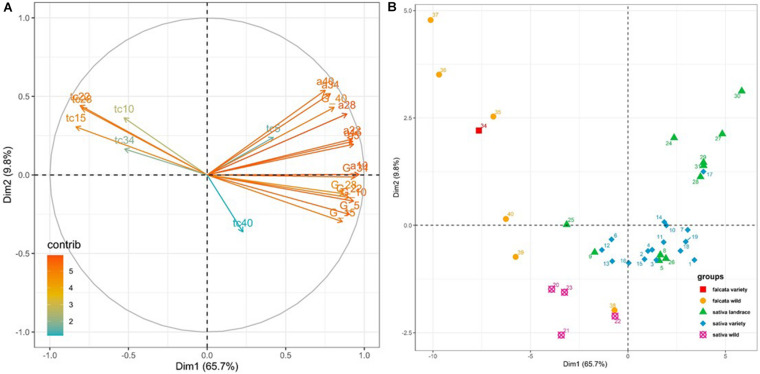
PCA on the parameters of seed germination collected on 38 accessions at 7 temperatures. (A) Contribution of the variables* to the first two axes, (B) Repartition of the accessions on the first two axes. The codes of the varieties are given in Table 1. *ymax for germinability, tc for the lag time to start germination, a for the rate of germination. ymax, tc and a are followed by the experimental temperature.